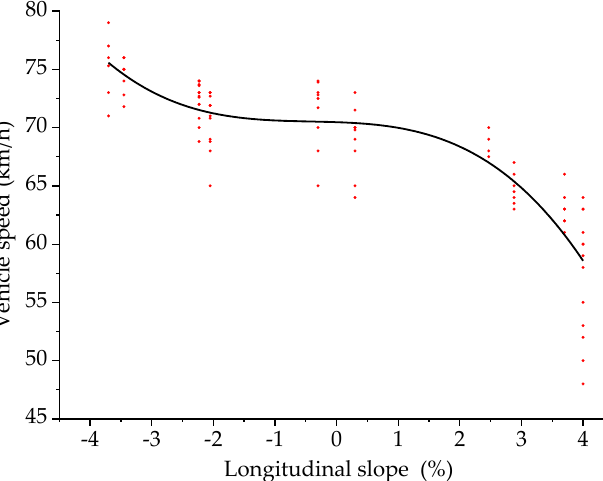
Figure 9. Fitting curve of the longitudinal slope and the vehicle speed.